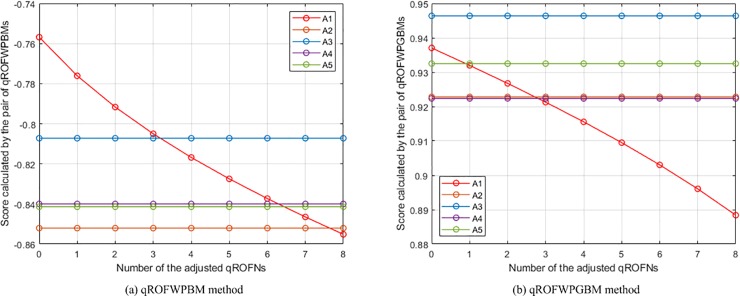
The changes of the places of A1 in the rankings of the WPBM and WPGBM methods.